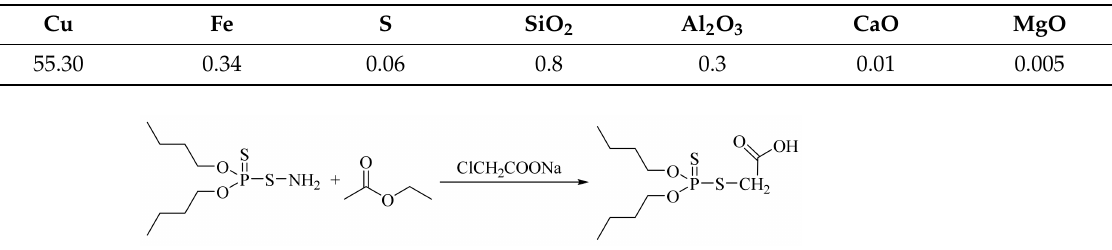
Figure 1. XRD pattern of the azurite samples. Table 1. Chemical composition of the pure azurite mineral.